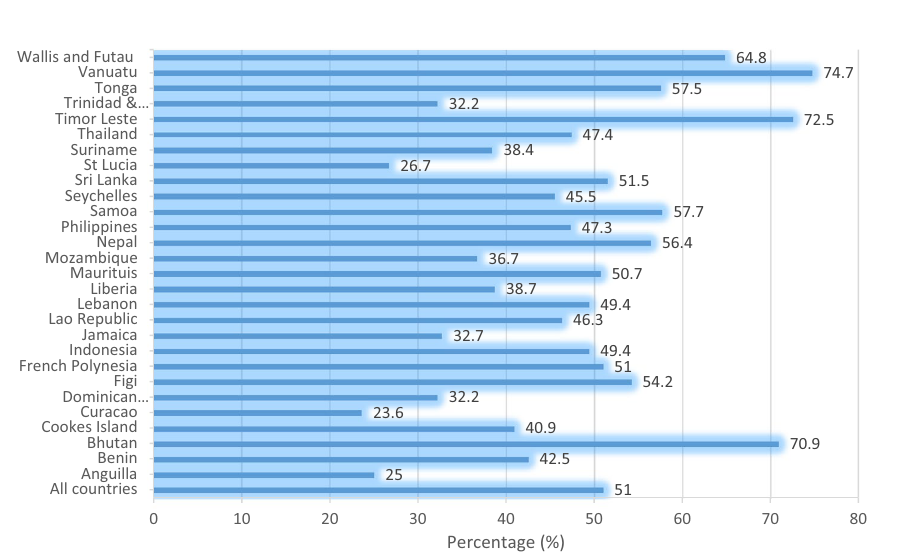
Figure 3. Prevalence of cigarette smoking across the 28 countries and